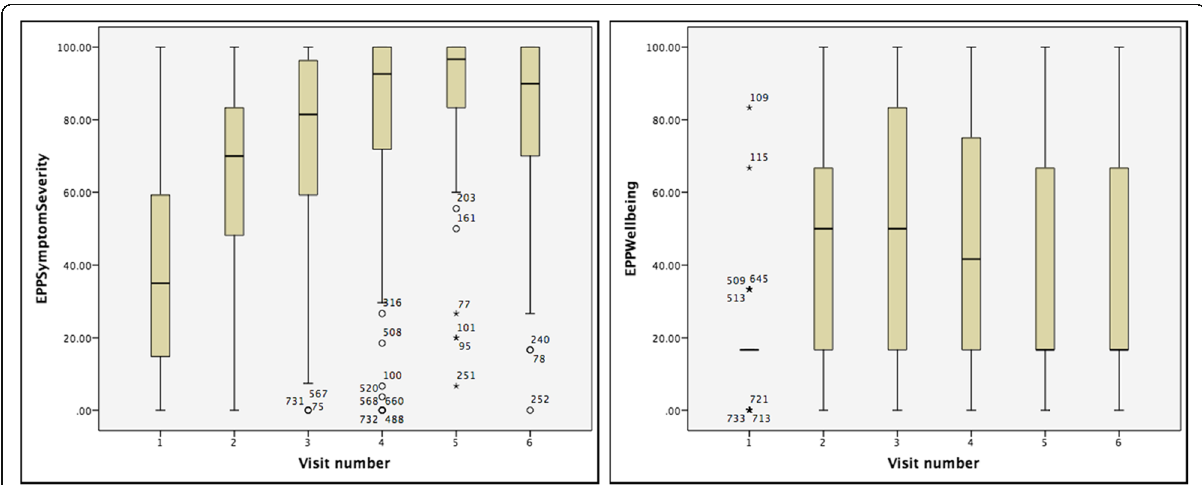
Fig. 1 a and b EPP Symptoms and EPP Wellbeing over time. Plots show median (broad bar), interquartile range or IQR (brown box), 1.5 times IQR (whiskers), circles and stars are